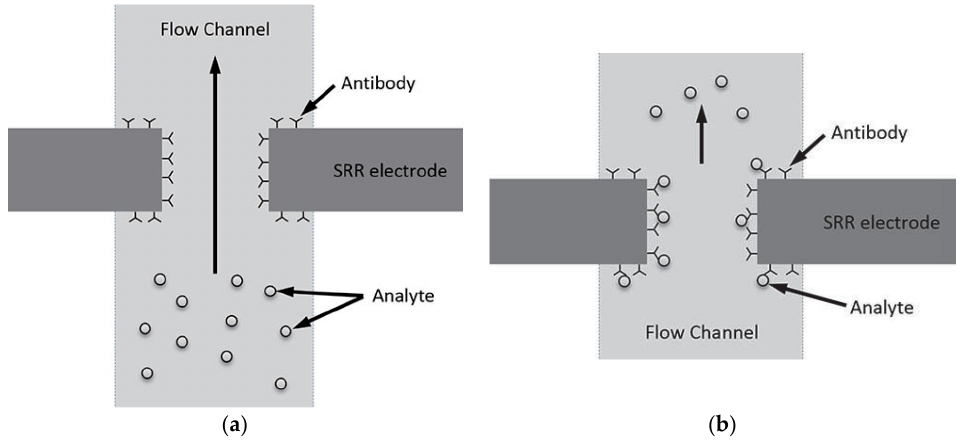
Figure 12. Antigen-antibody binding illustration: ( a ) before binding (with immobilized antibody around SRR electrode); and ( b ) after binding under analyte flow through a microfluidic channel (redrawn from [77]).